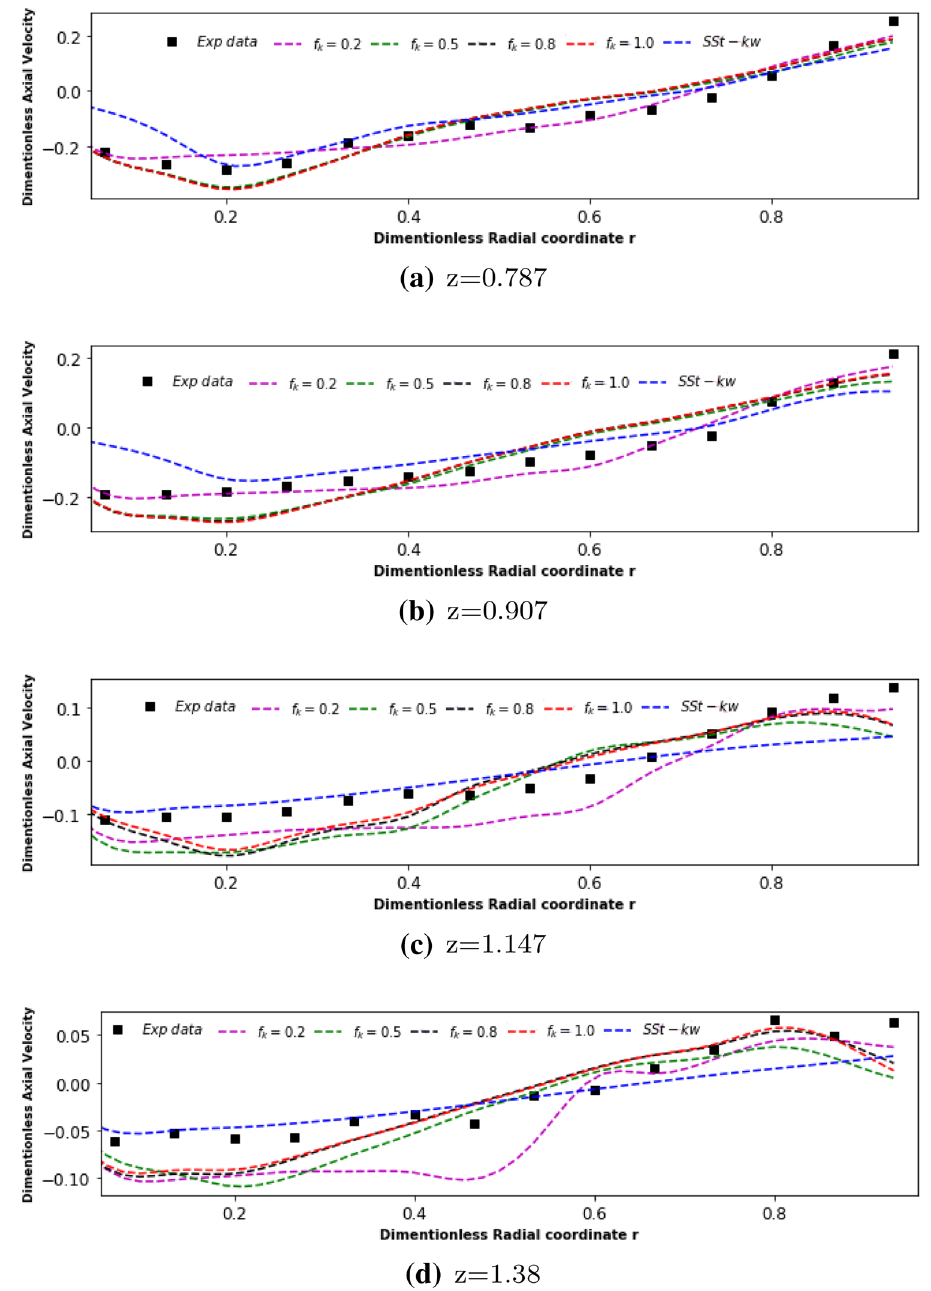
Fig. 9 Axial velocity profiles above the impeller at different z-location for f k = 0.2 ( - -- ), = 0.5 ( - - - ), f f k = 1.0 ( - - - ) of PANS k f k